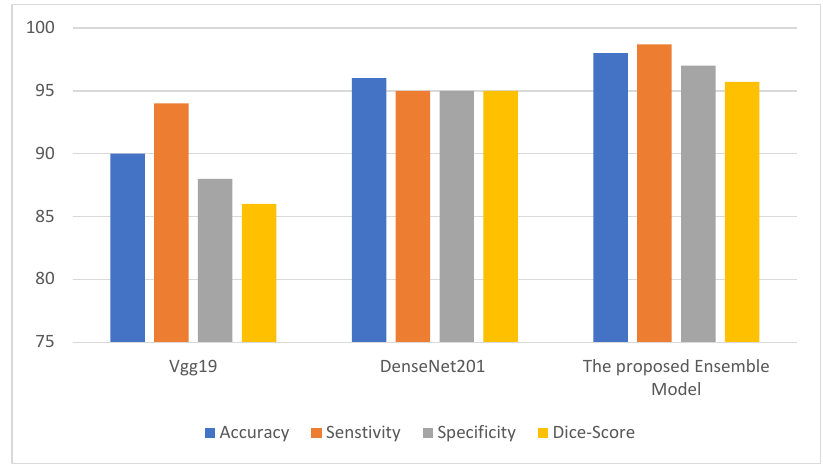
Behav. Sci. 2022 , 12 , x